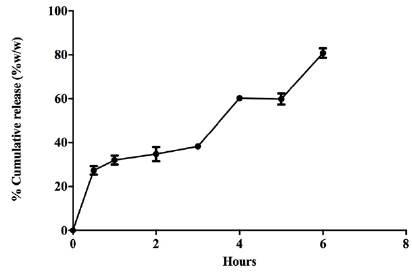
Figure 2. Vaccine release was evaluated under stomach pH conditions (pH 3) for 30 min, followed by intestinal pH conditions (pH 5) to estimate the amount of protein released from 10 mg of microparticles after oral dosing. Protein concentration was evaluated using the Biorad DC total protein assay method. About 70% of the vaccine remained encapsulated under stomach pH conditions. The microparticulate formulation resulted in the sustained release of the vaccine over a period of 6 h.